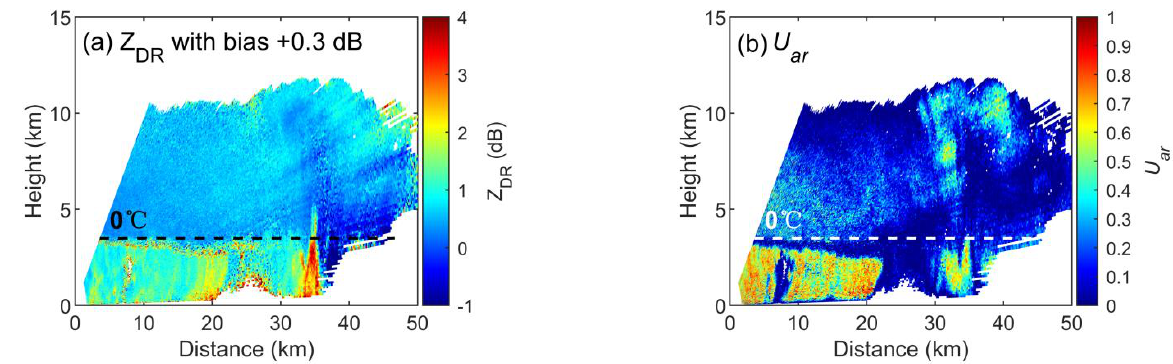
Figure 19. Sample of the impact on the U ar calculation when there is a +0.3 dB systematic deviation in Z DR at the X-band. ( a ) Z DR with bias +0.3 dB, ( b ) U ar . in Z DR at the X-band. ( a ) Z DR with bias +0.3 dB, ( b ) U ar